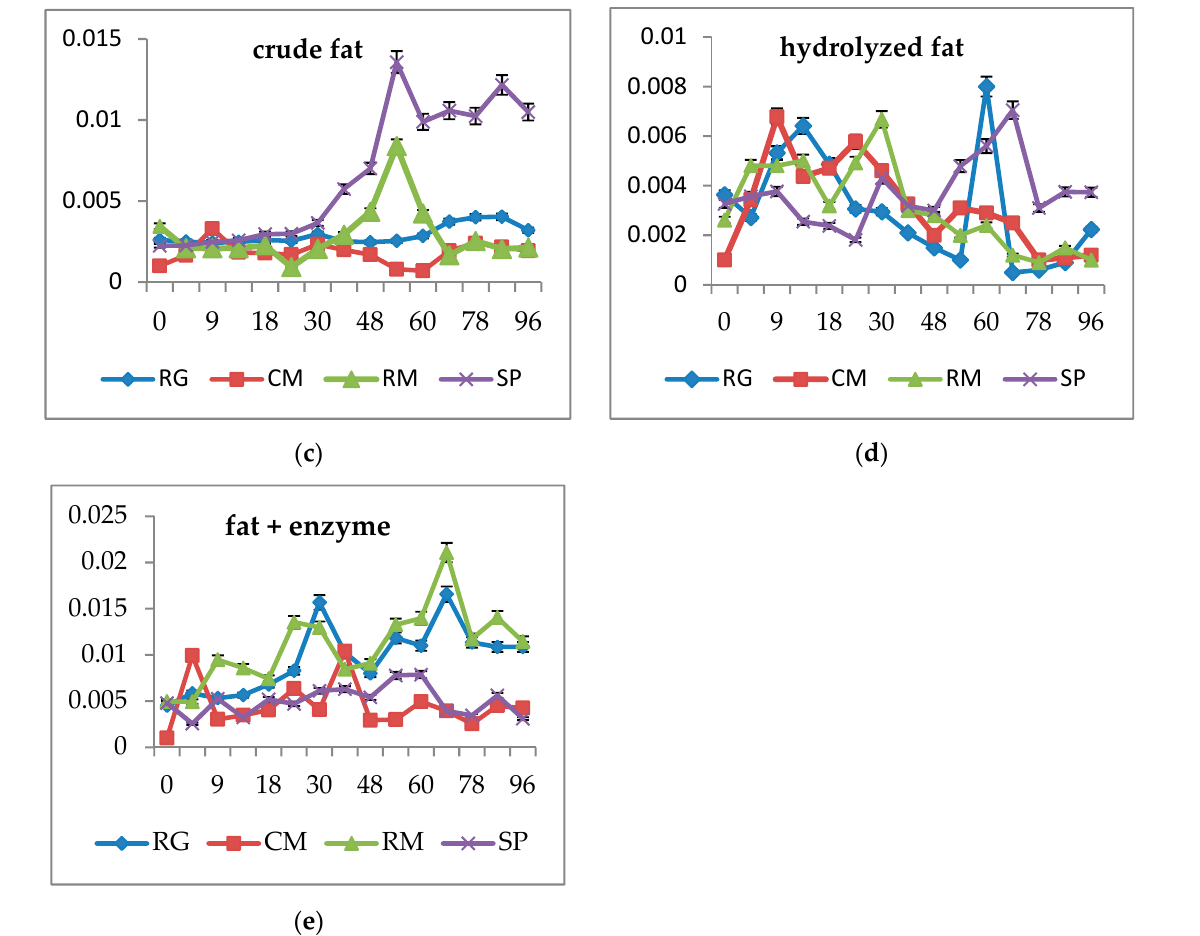
Figure 4. Changes of lipase production of individual strains during cultivation on different media. Lipase production in U/ml of medium was measured in the following media: ( a ) Medium with glucose; ( b ) medium with glycerol; ( c ) medium with crude animal fat; ( d ) medium with enzymatically hydrolyzed fat; ( e ) medium with animal fat and the addition of lipase. The production of lipase on the emulsified medium was not detected. Abbreviations: RG ( Rhodotorula glutinis CCY 20-2-26), CM ( Cystofilobasidium macerans CCY 10-1-2), RM ( Rhodotorula mucilaginosa CCY 19-4-6), and SP ( Sporobolomyces pararoseus CCY 19-9-6).